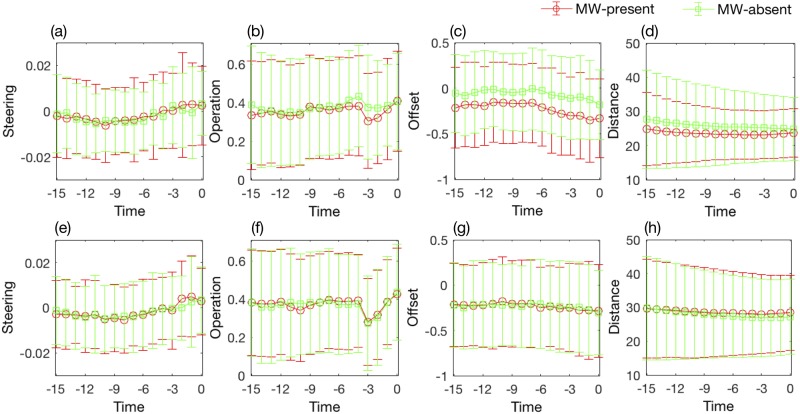
The one standard deviation along the mean of selected variables in the 15s window just before the tone probe calculated across MW-present and MW-absent samples of participants with high or low MW (a, b, c, d), and of participants with medium MW (e, f, g, h).The ‘0s’ on the ‘Time’ axis is corresponding the time of tone probe appearing.